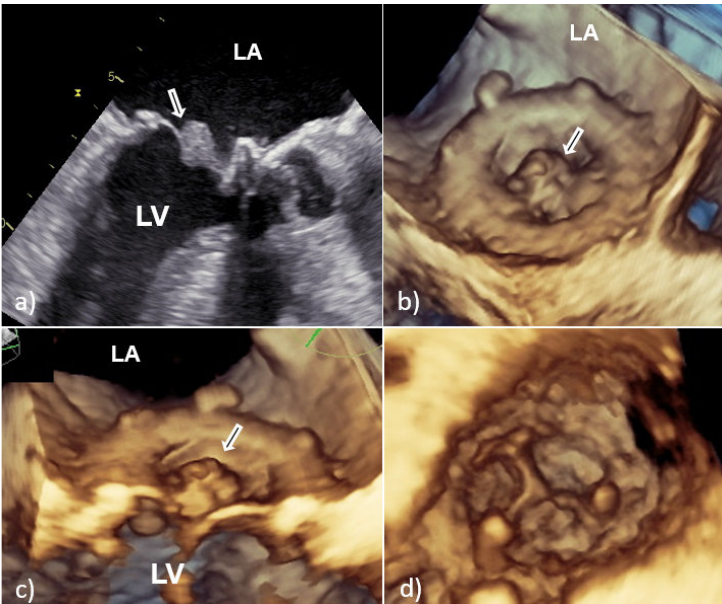
Figure 3. Transesophageal echocardiography of mitral bioprosthesis endocarditis caused by Enterococcus faecalis : 2D TEE ( a ) and 3D TEE view ( b , c ) from the atrial side showed a sedentary type of vegetation (white arrow) clinging to the leaflet with a wide base; view from the left ventricle showed good leaflet appearance and coaptation with no possible complications of PVE ( d ). 2D TEE—two-dimensional transesophageal echocardiography; 3D TEE—three-dimensional transesophageal echocardiography; PVE—prosthetic valve endocarditis; LA—left atrium; and LV—left ventricle.